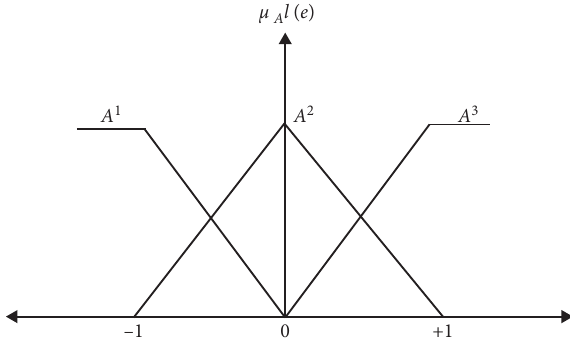
Figure 2: Input membership functions for the designed TSK fuzzy system.